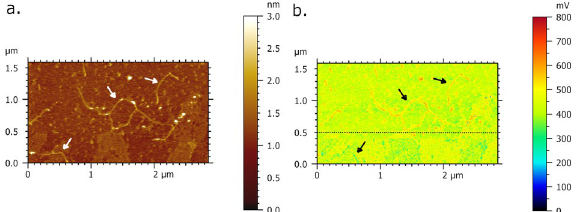
Figure 4. AFM-IR imaging of single DNA molecule deposited onto Ni 2+ -functionalized mica surface. ( a ) AFM morphology map and corresponding ( b ) AFM-IR absorption maps of single DNA with a higher (red contour) and lower (blue/green contour) absorbance acquired at laser pulse tune configuration with fixed frequencies at 1664 cm −1 (above dashed line) and 1550 cm −1 (below dashed line),